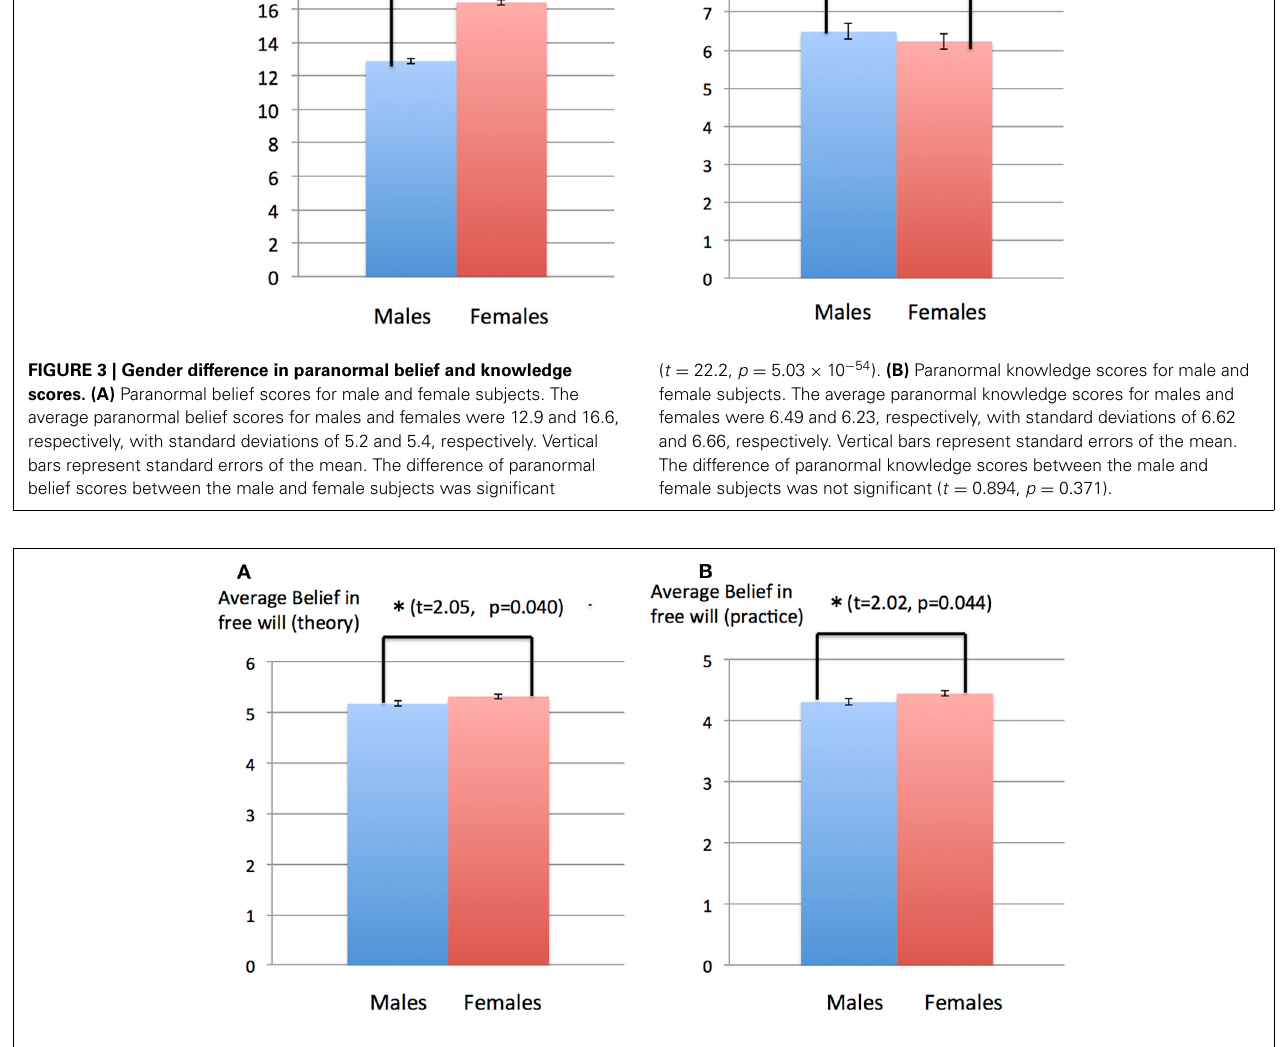
FIGURE 4 | Gender difference in the belief in free will (theory and practice). (A) Belief in free will (theory) for male and female subjects. The average belief in free will (theory) were 5.18 and 5.32 for male and female subjects, respectively, with standard deviations of 1.68 and 1.44, respectively. Vertical bars represent standard errors of the mean. The difference between